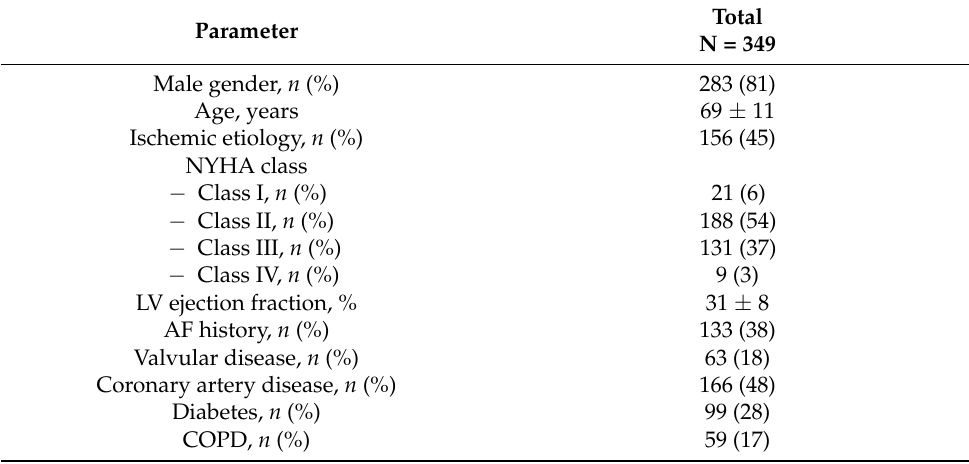
Table 1. Demographics and baseline clinical parameters of the study